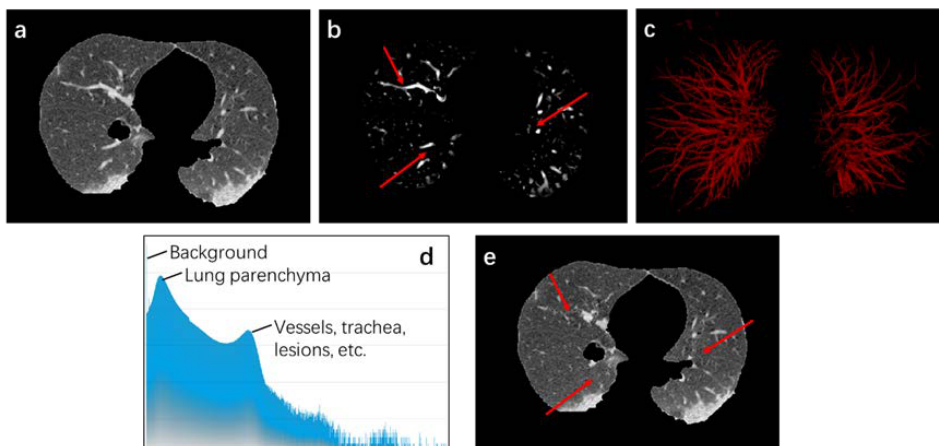
Figure 4. Data Enhancement process. ( a ) represents the original data; ( b ) shows the enhanced data; for the convenience of observation, ( c ) is segmentation result under 0.8 threshold; ( d ) reveals gray histogram of original data; ( e ) is result after data enhancement. The area pointed by the red arrows in ( b , e ) was suppressed after data enhancement.